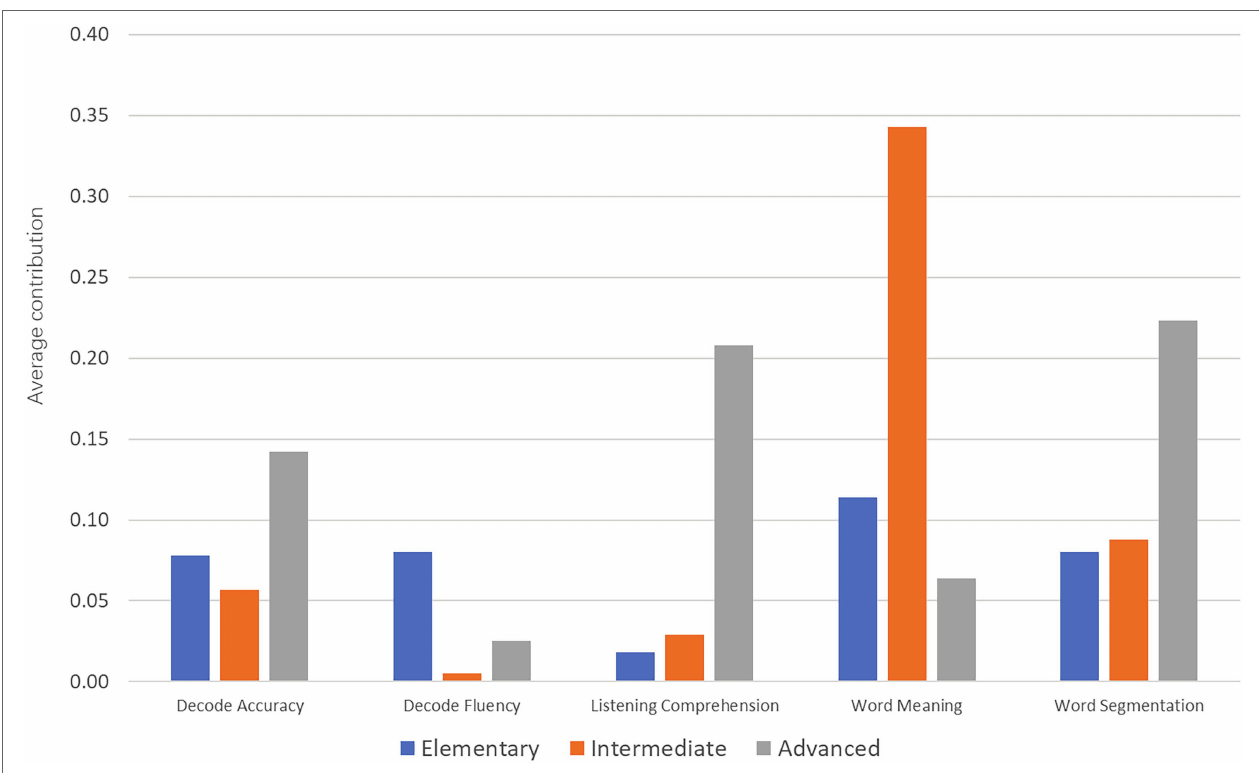
FIGURE 1 | The average contribution of each predictor at the three groups of